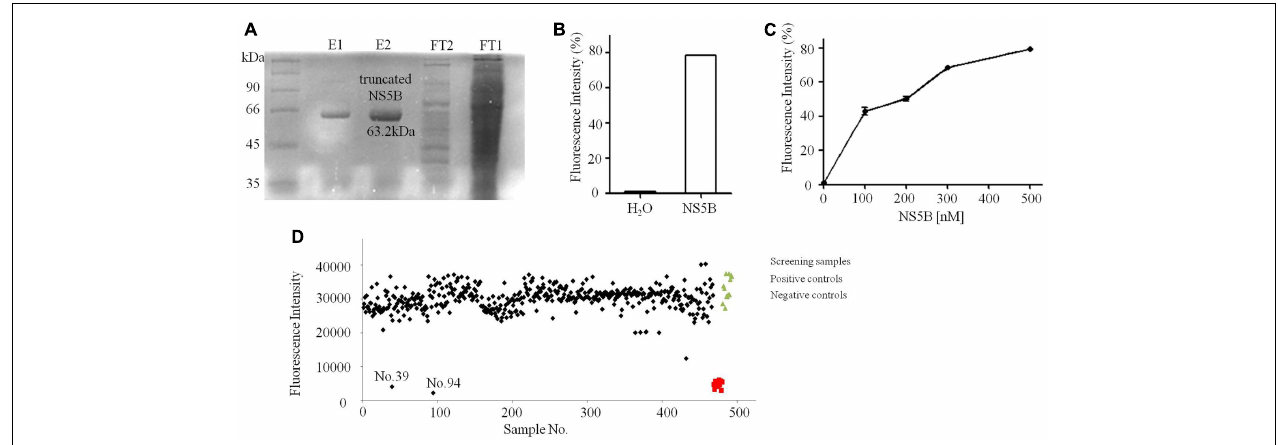
FIGURE 4 | Purification and FI based dsRNA formation assays of truncated NS5B. (A) Coomassie stained SDS-PAGE gel analysis of purified truncated NS5B with 6 × His tags. (B) Truncated NS5B catalyzed dsRNA formation (adding H 2 O or 300 nM truncated NS5B in reaction system). (C) The effect of truncated NS5B concentration on dsRNA formation measured using the PicoGreen. (D) About 800 small molecular compounds and crude extracts were screened using the FI system.